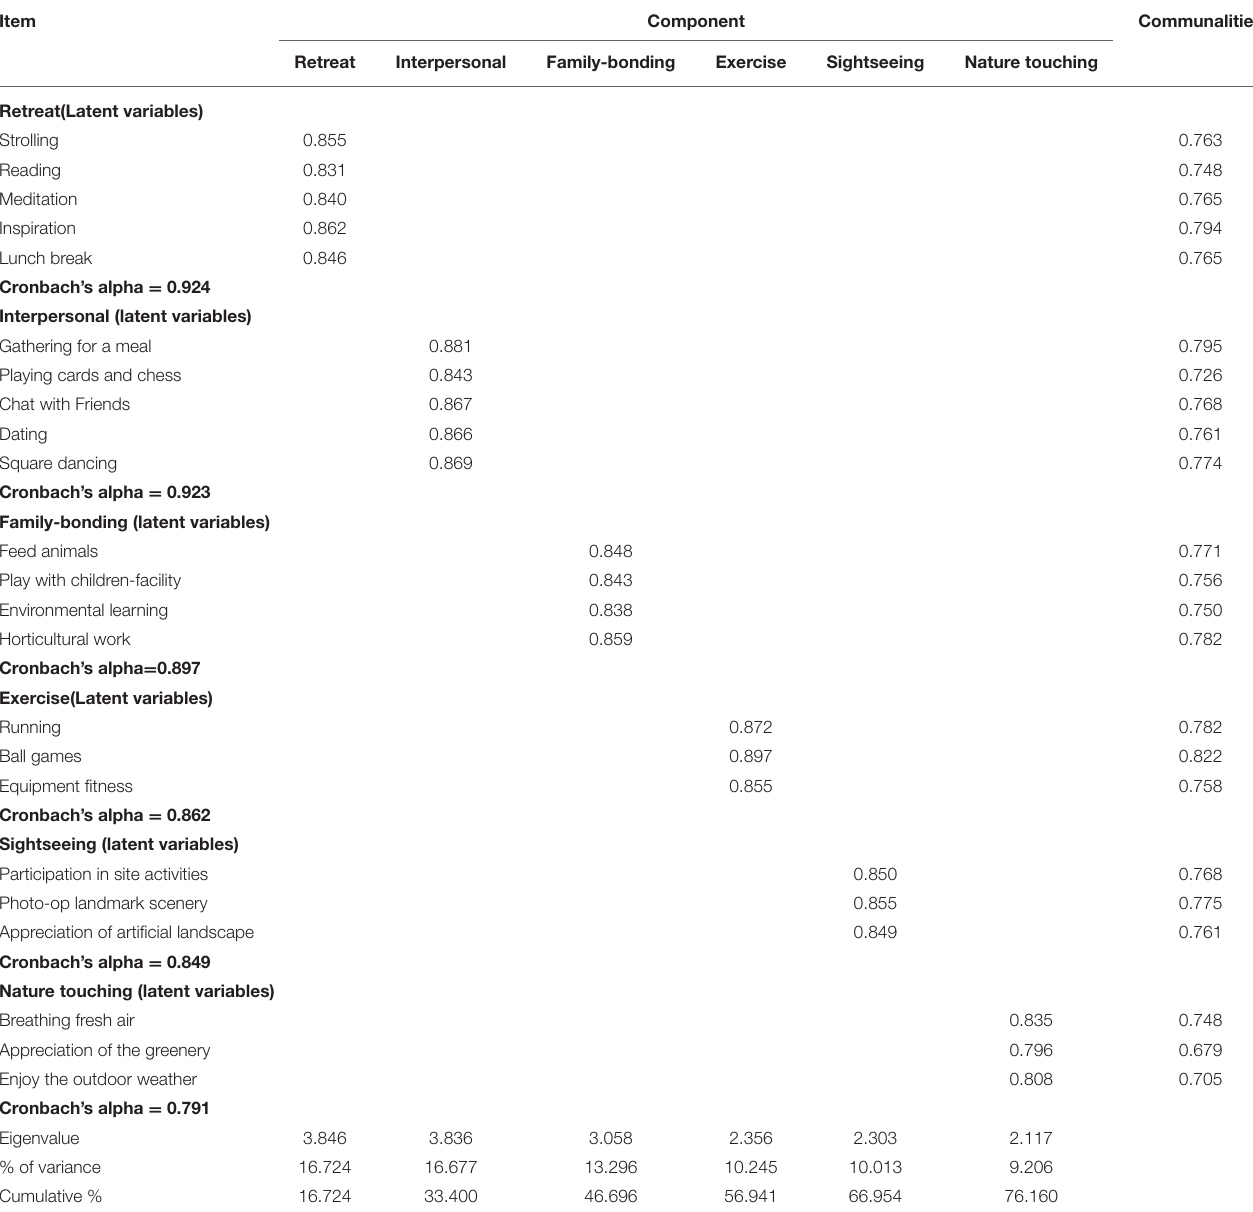
TABLE 4 | Corrected correlations between UPs items and UPs. Item Component Communalities Retreat Interpersonal Family-bonding Exercise Sightseeing Nature